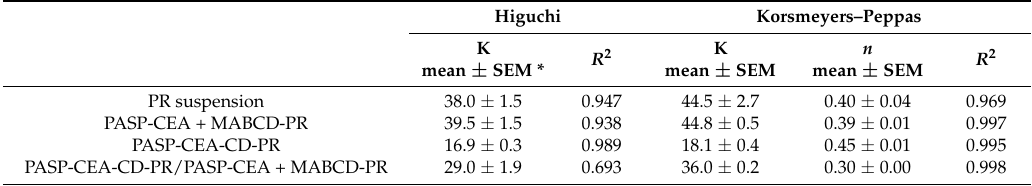
Table 2. Release rate constants obtained by the fitting of the release profiles (1–8 h) to the Higuchi, and Korsmeyer–Peppas